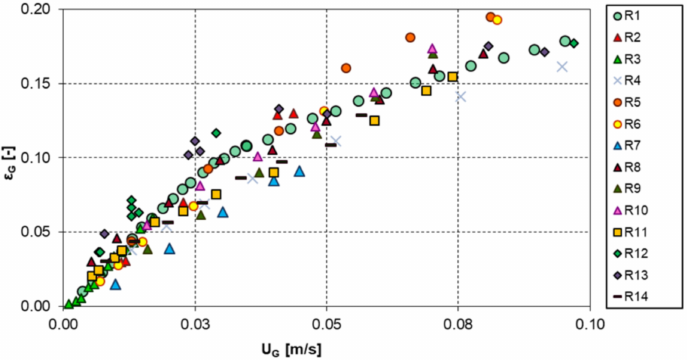
Figure 14. Literature